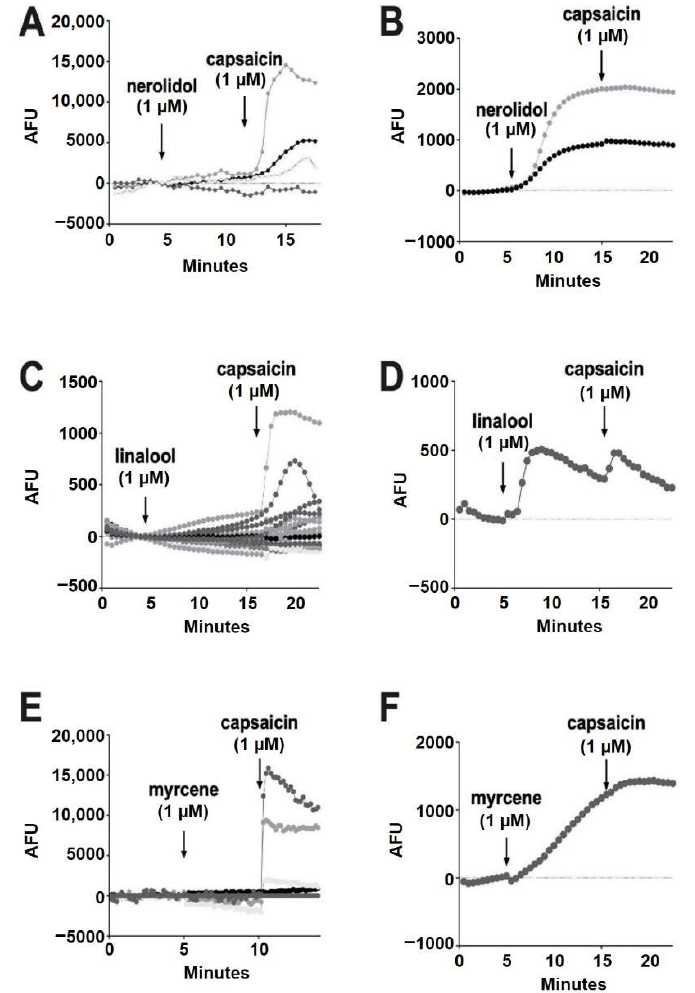
Figure 6. Nerolidol, linalool and myrcene do not reliably activate calcium responses in DRGs. ( A ) Sample population response using a calcium sensor in DRGs treated with nerolidol (1 µ M) followed by capsaicin (1 µ M). ( B ) Infrequently (7% of neurons), nerolidol elicited a sustained calcium response as shown in these sample time courses. ( C ) Time course showing responses to linalool (1 µ M) as in A. ( D ) Rarely (0.86%) linalool elicited a response in DRGs. ( E ) Time course showing responses to myrcene (1 µ M) as in A. ( F ) Myrcene rarely (1.3%) elicited a calcium response in DRGs.